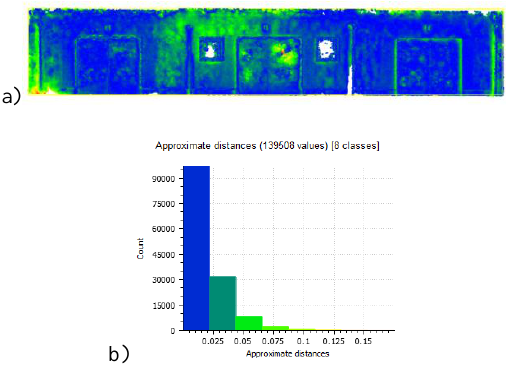
Figure 11. Accuracy assessment of a point cloud generated from video frames with low-pass filtration and histogram equalization with reference to TLS data a) in graphical form and b) as a